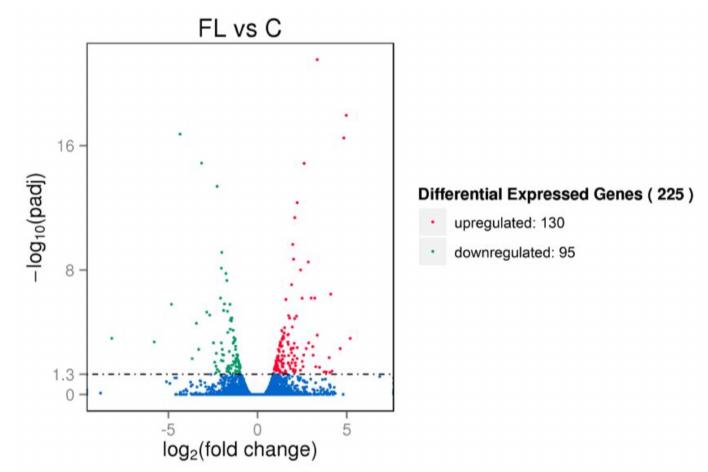
Figure 6. Volcano plot of differentially expressed genes (DEGs). Red, green and blue points represent significantly upregulated, downregulated and non-regulated genes, respectively. The abscissa is the fold change of the genes in different samples, ordinate is the variation difference of the gene expression with statistical significance. FL: paternal inheritance group, C: control group.